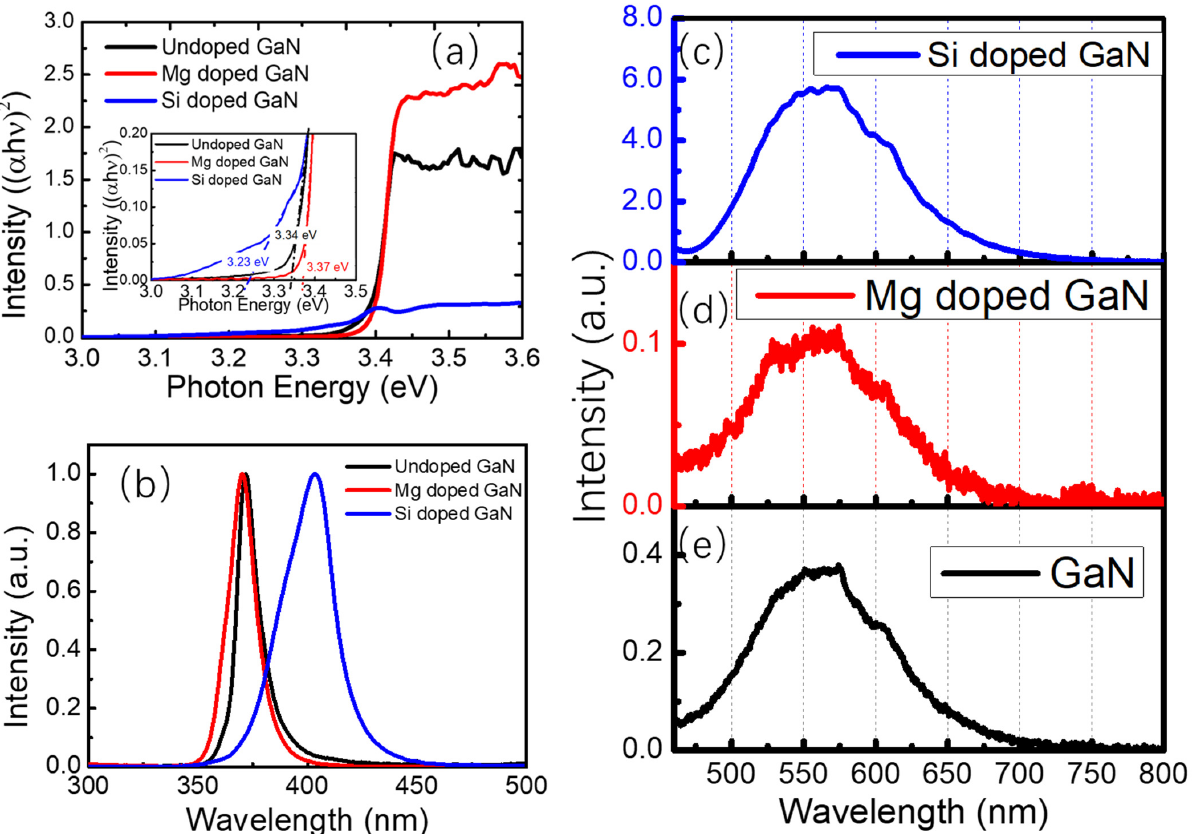
Figure 3. ( a ) Room temperature ground state absorption spectra of undoped, Mg-doped, and Si- doped GaN thin films (the inset is the bandgap calculated by using Tauc plot absorption curves). ( b ) Normalized photoluminescence of undoped, Mg-doped, and Si-doped GaN thin films excited by using a 355 nm continuous wave laser; defect luminescence spectra of ( c ) Si-doped GaN, ( d ) Mg-doped GaN, and ( e ) undoped GaN thin films.